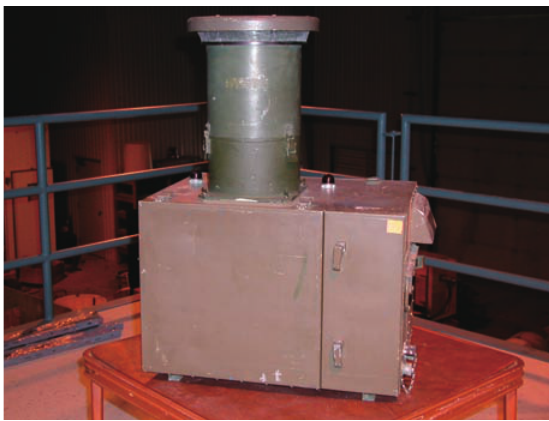
Fig. 2 XM19 biological detector showing the virtual impactor stack.